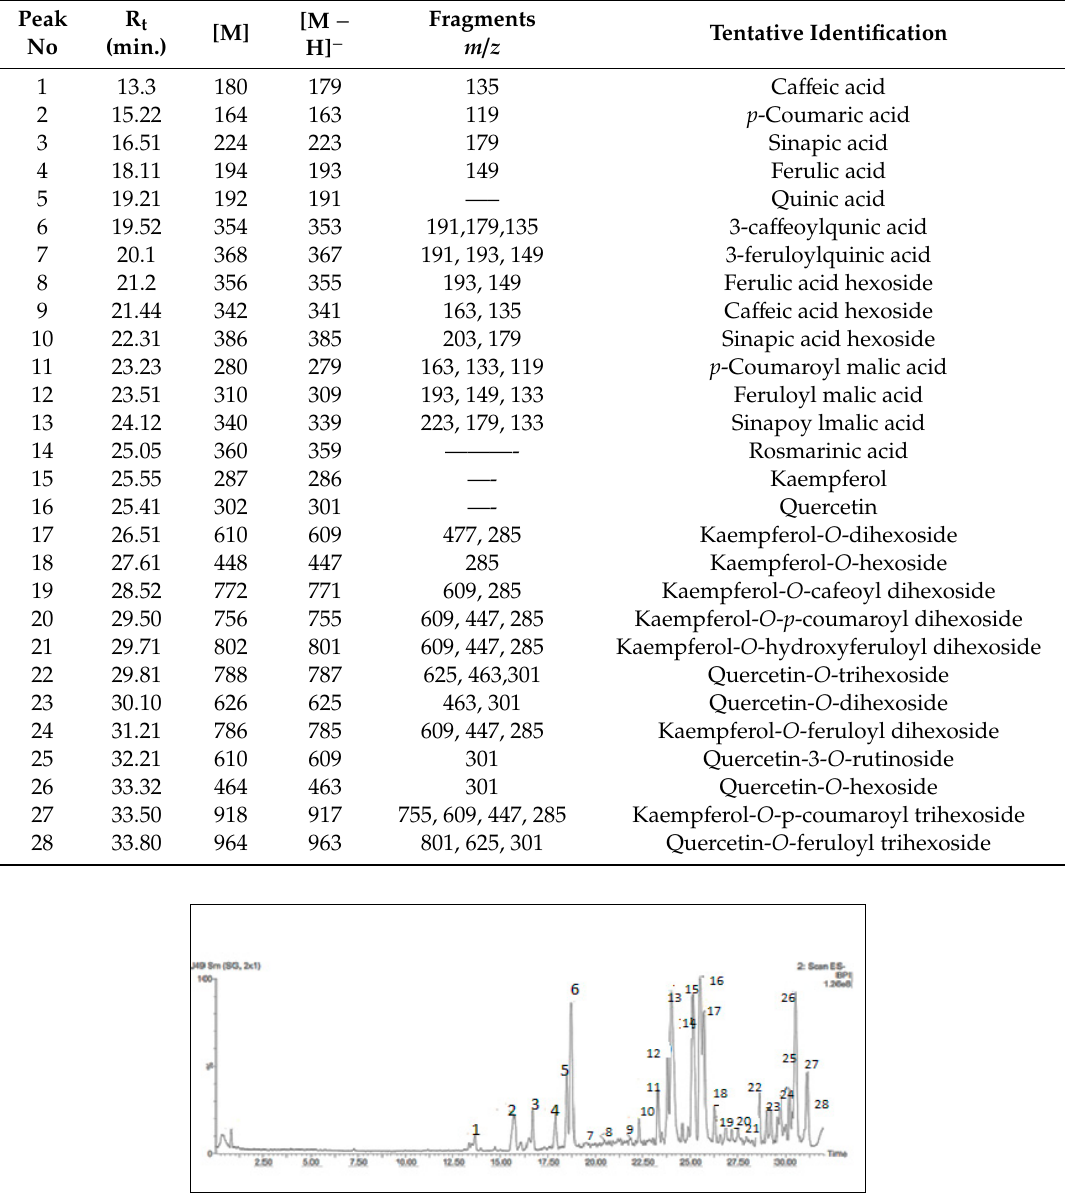
Figure 3. Total ion chromatogram of LC–MS of ethanolic extract of MS.